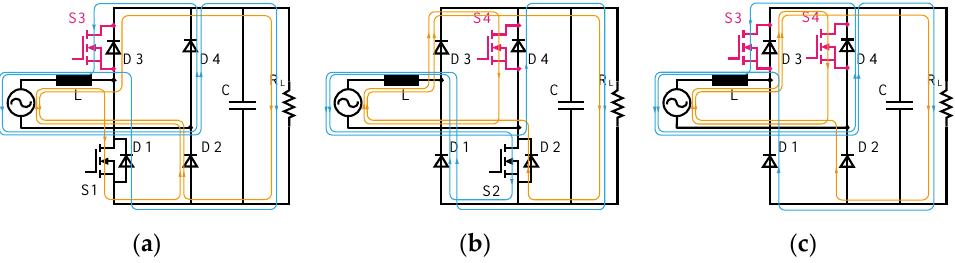
Figure 10. Circuit type reconfigurations. ( a ) Totem pole bridgeless; ( b ) Symmetry totem pole bridgeless; ( c ) Symmetry boost bridgeless.